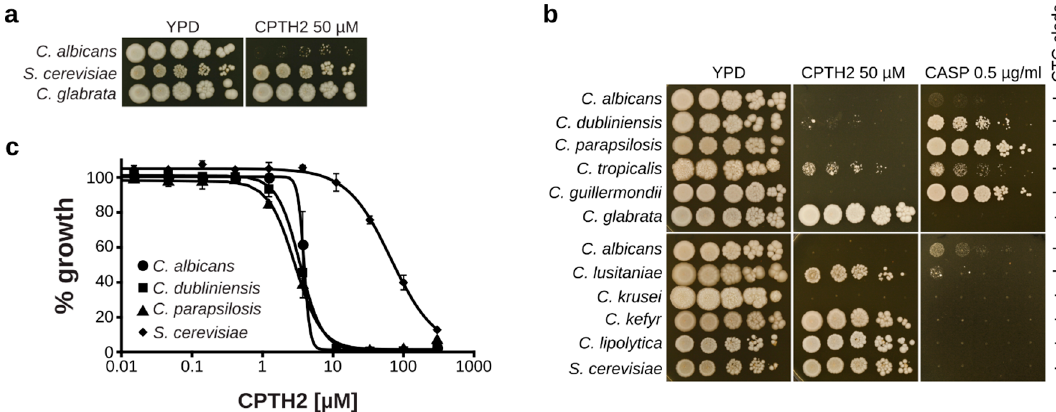
Figure 3. CPTH2 primarily inhibits CTG clade Candida species. ( a ) Spot dilution assay of C. albicans , S. cerevisiae , and C. glabrata on YPD plates. Only C. albicans shows clear growth inhibition at 50 µM CPTH2. ( b ) Spot dilution assays of different Candida species on plates containing either CPTH2 or caspofungin (CASP). CTG clade membership of the respective species is indicated on the right. ( c ) Liquid growth inhibition assay in YPD medium. Fungal strains were incubated with the indicated concentrations of CPTH2 for 24 h prior to OD 600 measurement. Data shown are mean ± sd of four biological replicates.